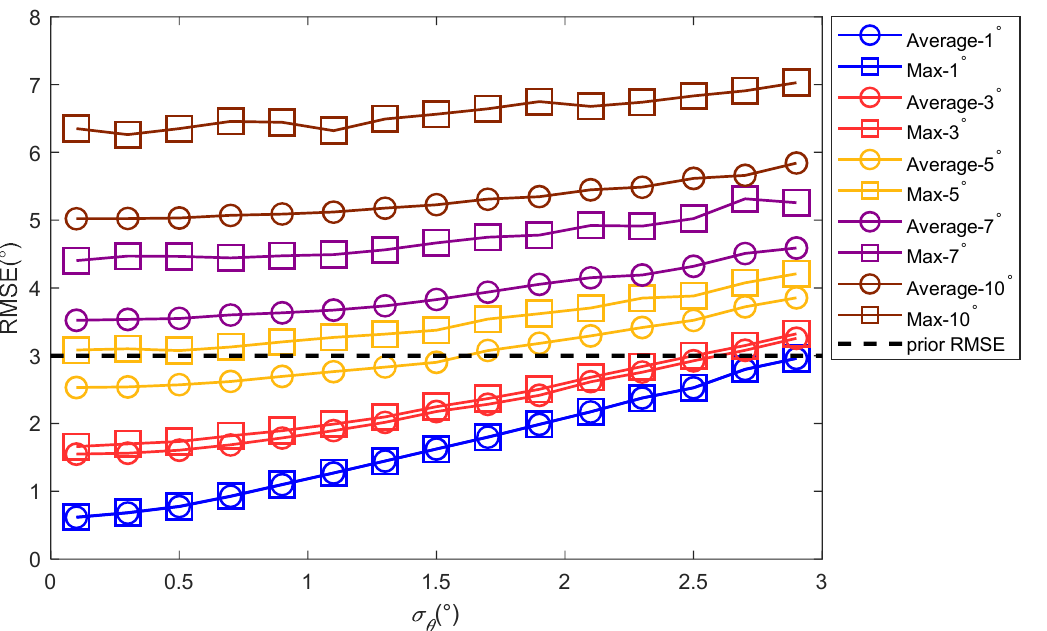
Figure 12. The elevation angle’s estimate accuracy varies with the angle’s standard deviation for the traditional methods.